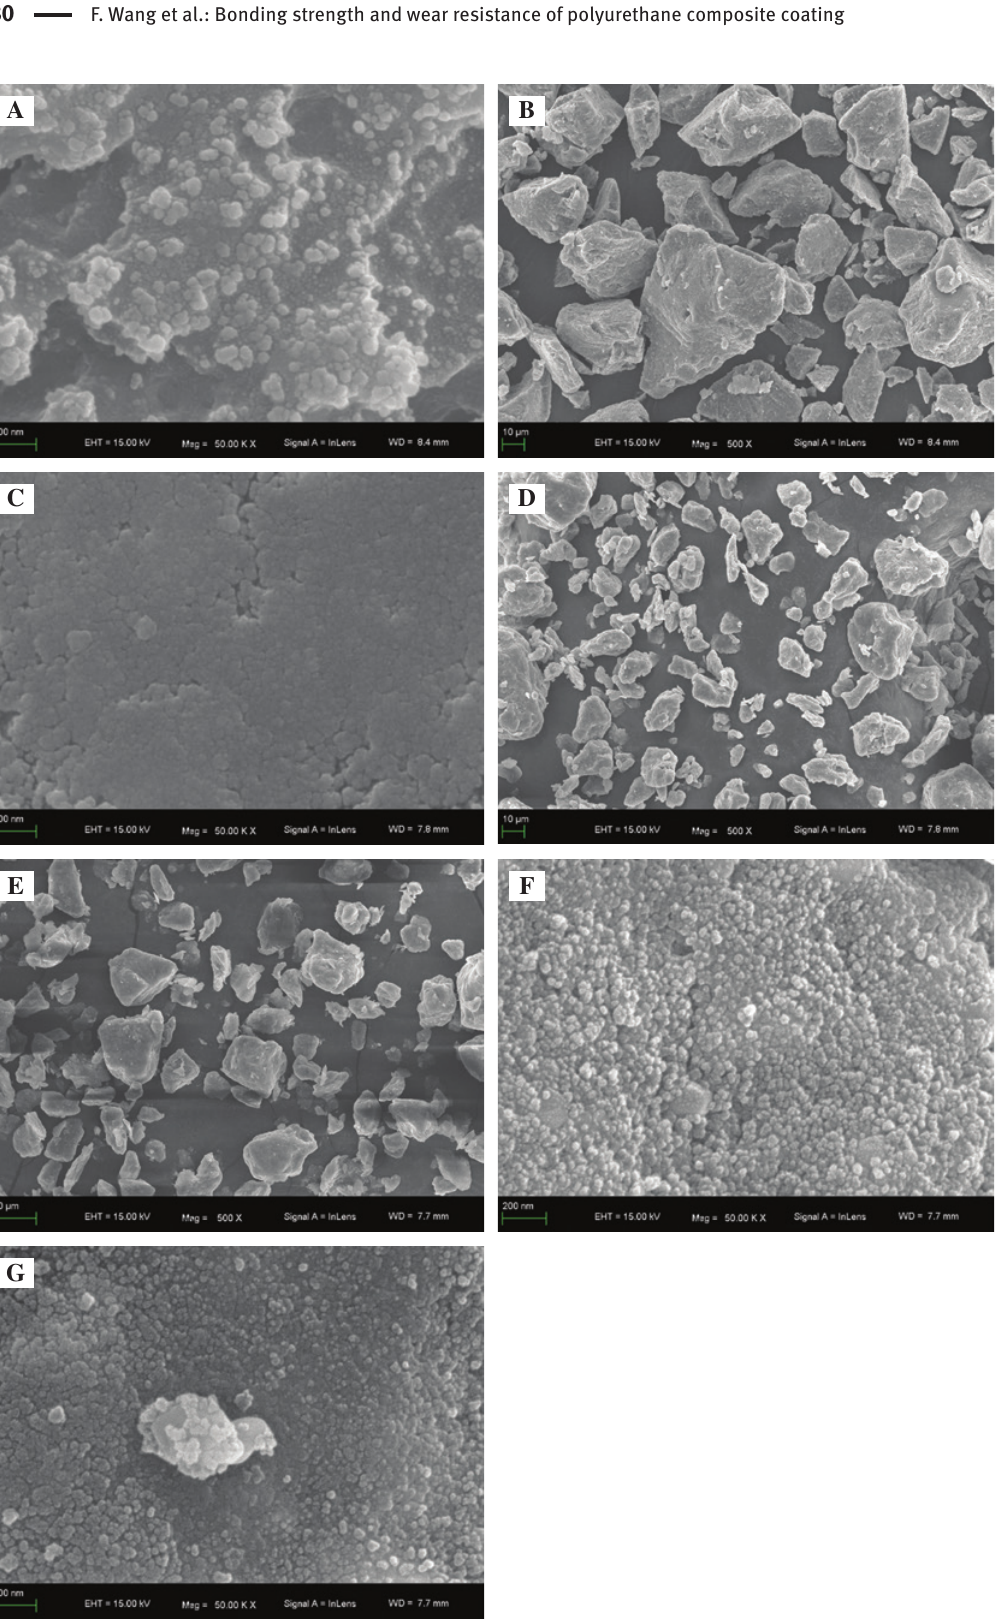
/PU after ball milling, and (E and G) 2